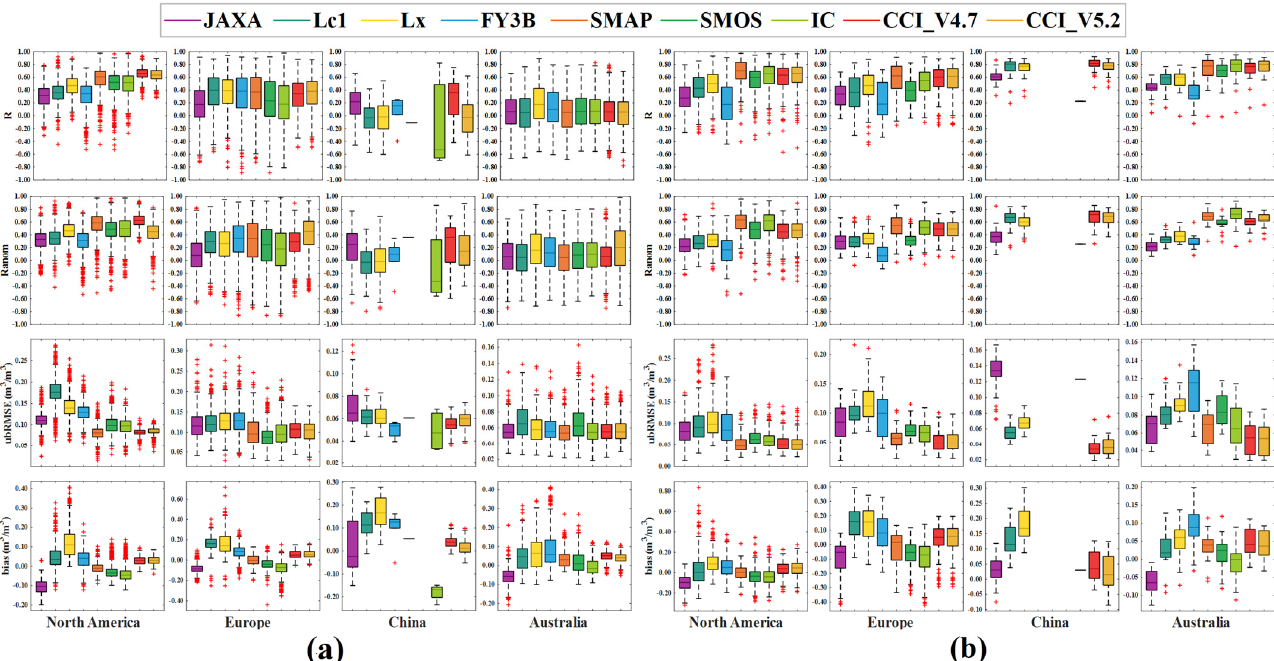
Figure 6. Boxplots of assessment metrics of each product at ( a ) the temporal scale (metrics calculated for each day) and ( b ) the spatial scale (metrics calculated for each site), partitioned by continents. As shown in Table 1, SMAP and CCI products performed better in most instances.